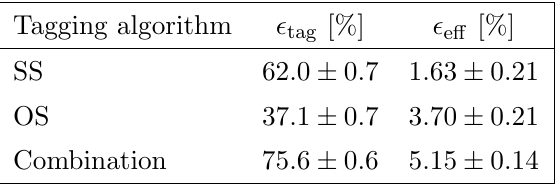
Table 3 . The (cid:13)avour-tagging performance of the SS and OS tagging algorithms, as well as the combination of both, for the signal data sample used in the analysis. The quoted uncertainty includes both statistical and systematic